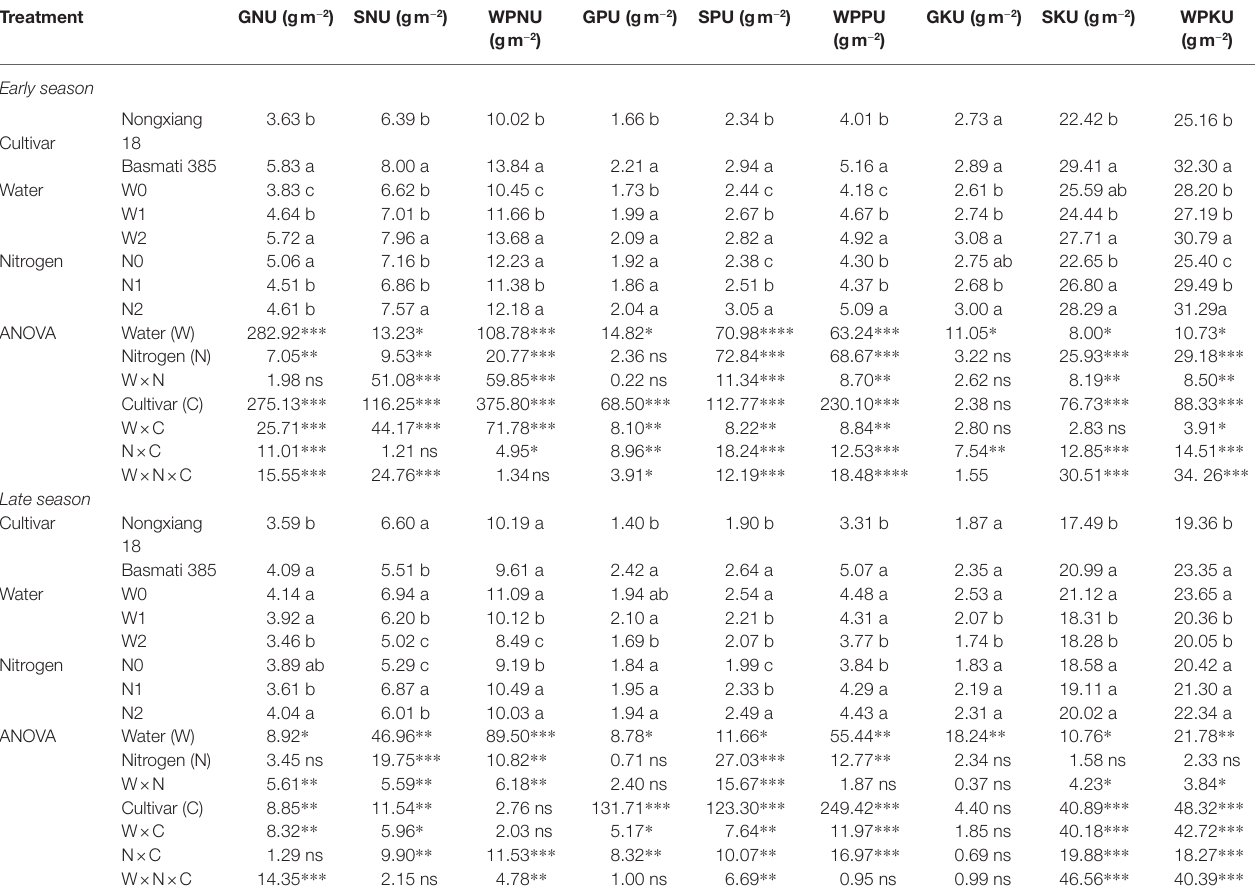
TABLE 6 | The N, P, and K uptake in grain, straw, and the whole plant as affected by water, nitrogen, and cultivar in the early and late seasons double rice cropping systems in South China.